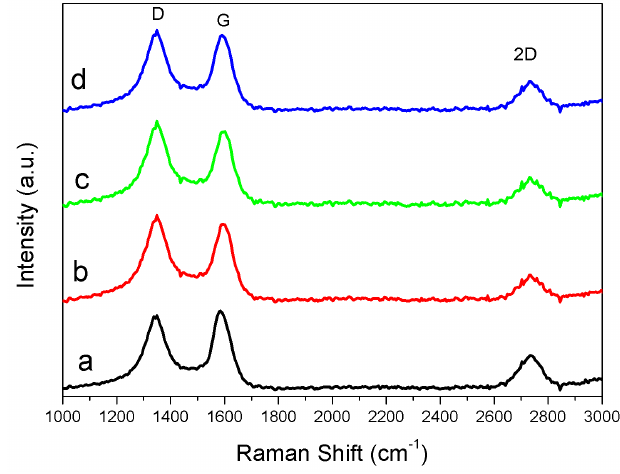
Figure 4. Raman spectra of thermally treated Fe-lignin samples prepared using different iron sources as catalysts: Fe-N ( a ), Fe-Cl 3 ( b ), Fe-Cl 2 ( c ) and Fe-S ( d